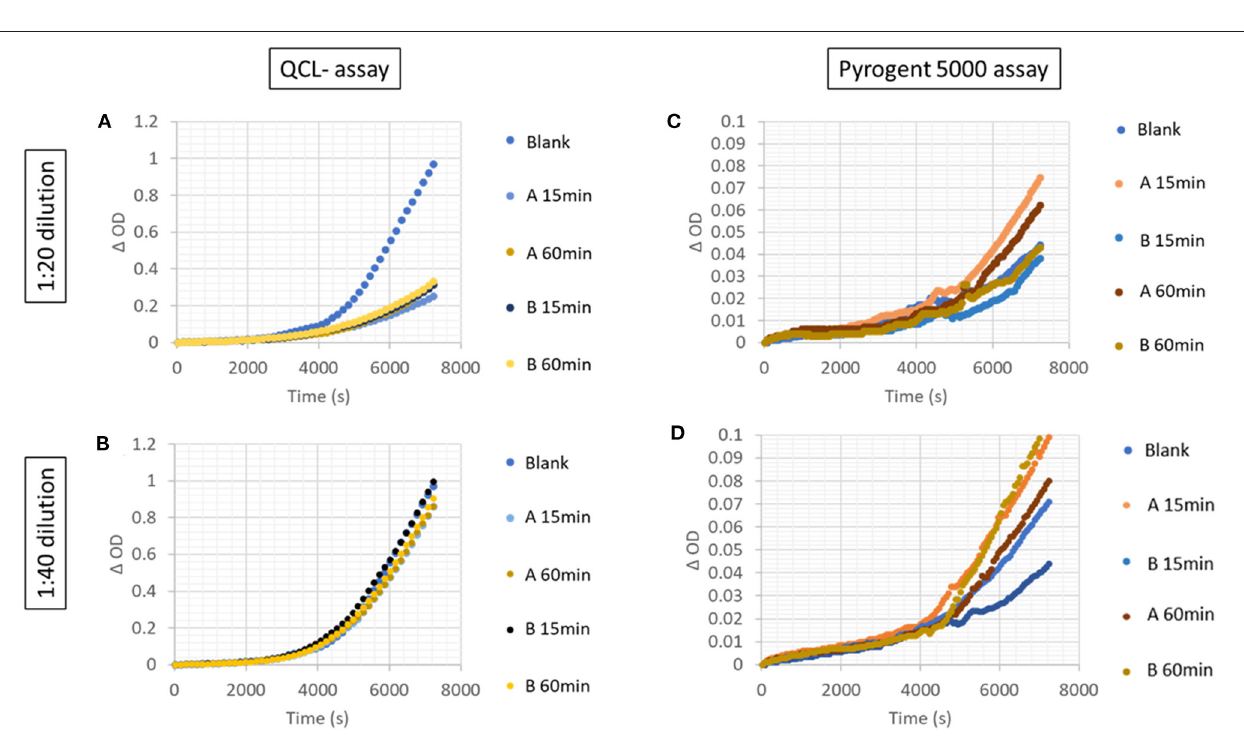
FIGURE 4 | Increase in signal over time in serially diluted unspiked serum samples with the (A,B) QCL and (C,D) Pyrogent-5000